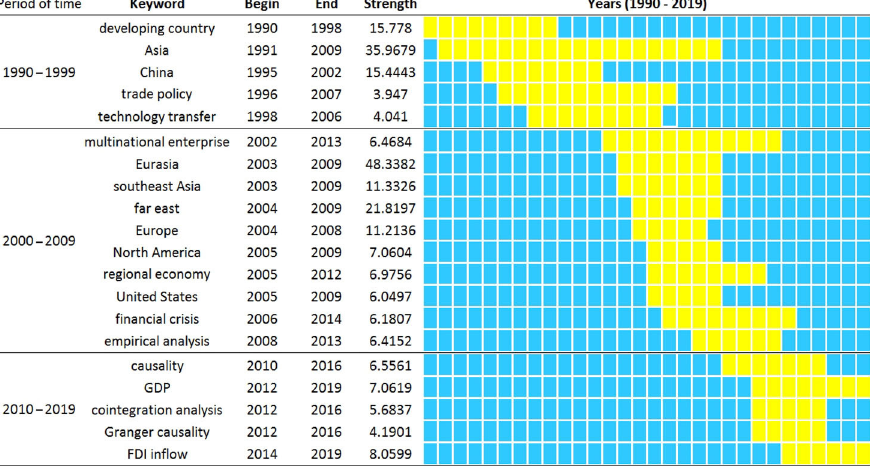
Figure 7. Top keywords with citation burst between 1990–2019 (source: Scopus, using